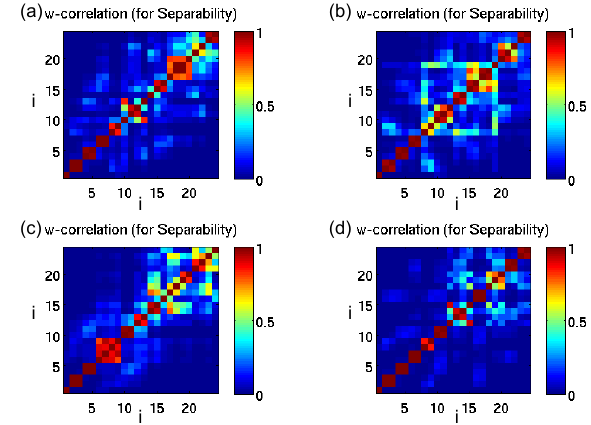
Fig. 16. w correlation with the 24 reconstructed time series. (a) Nakuru, (b) Naivasha, (c) Narok, and (d) Kisumu. When the mode Fig. 16. w-correlation with the 24 reconstructed time series. (a) for the reconstructed time series is higher, the separability becomes Nakuru, (b) Naivasha, (c) Narok, and (d) Kisumu. When the mode weaker because more different colour cells indicating the correla- for the reconstructed time series is higher, the separability becomes tion with other modes are illustrated in the row and column direc- weaker because more different color cells indicating the correlation with other modes are illustrated in the row and column directions of tions of each reconstructed time series in the each reconstructed time series in the results. Table 4. Parameter combinations of the precipitations for SST. b : a time length of both past and future parts, (cid:13) : a start position of the subtime series in the future part from the reference time, L SST : a window length for these subtime series, l : the number of the left singular vectors of the past part to span a hyperplane.